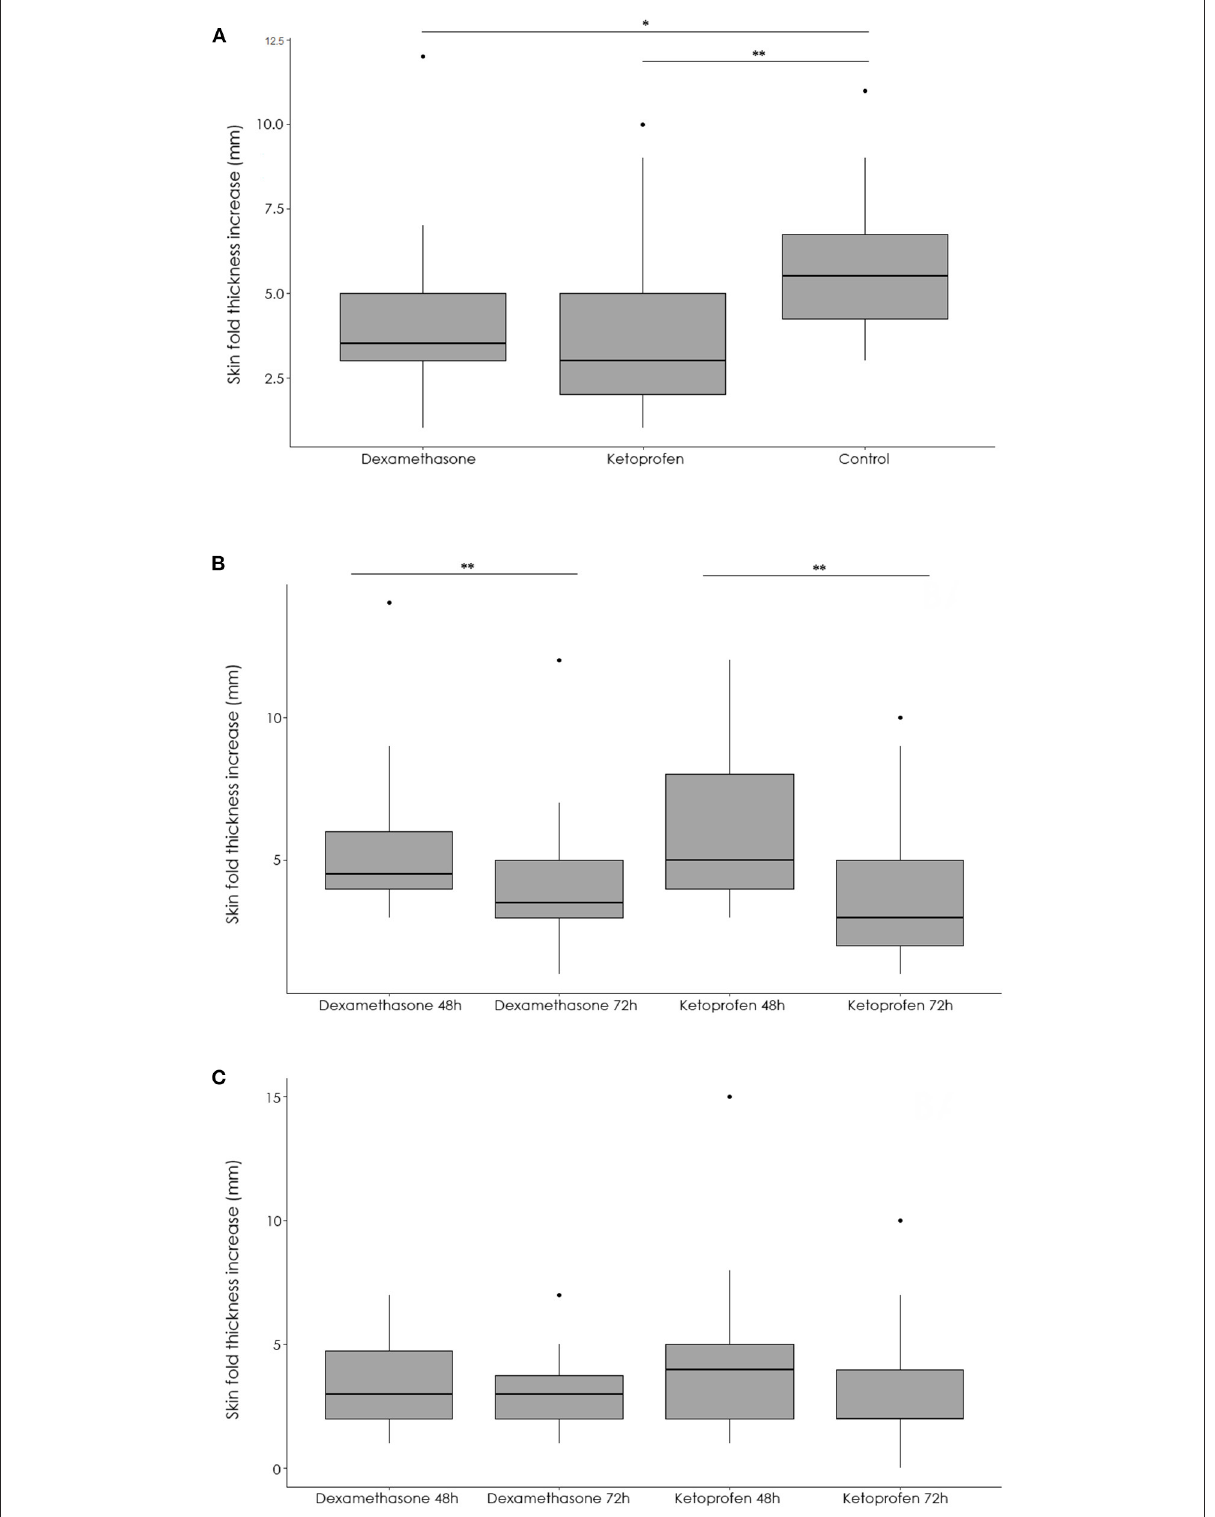
FIGURE2 Summary of the differences among median skin fold thickness (mm) after bovine PPD injection in the dexamethasone, ketoprofen and control groups at day 3 (A) , and after bovine (B) and avian (C) PPD injection in the dexamethasone and ketoprofen groups at 48h and 72h. * p = 0.005, ** p <